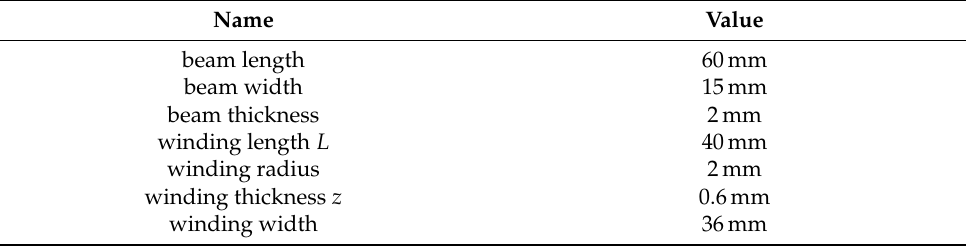
Figure 1. The mold for preparing sample beams ( a ). Example of performed beams ( b ). The gripper finger mold ( c ). The example of gripper finger ( d ). Table 1. The dimensions of beam and coil.